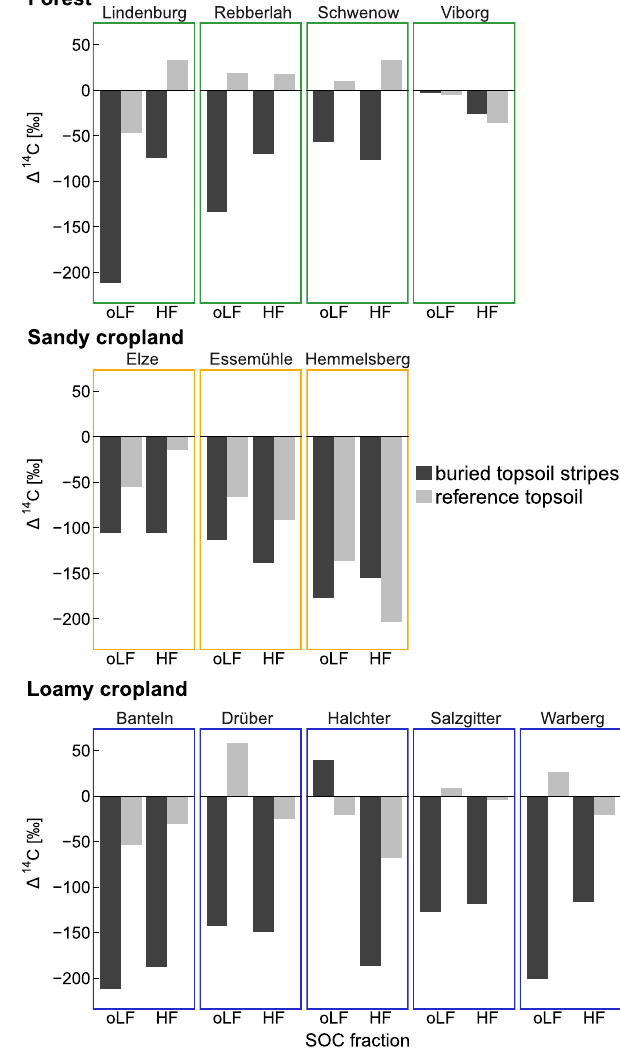
Figure 6. Δ 14 C values obtained for occluded light fraction (oLF) and heavy fraction (HF) of SOC in buried topsoil stripes and reference topsoil. Positive values signify that nuclear test- derived 14 C was incorporated into the SOC fraction (young apparent 14 C age). Negative values indicate that soil fraction carbon exchange with the atmosphere has been slow and that significant radioactive decay has occurred (old apparent 14 C age) 35